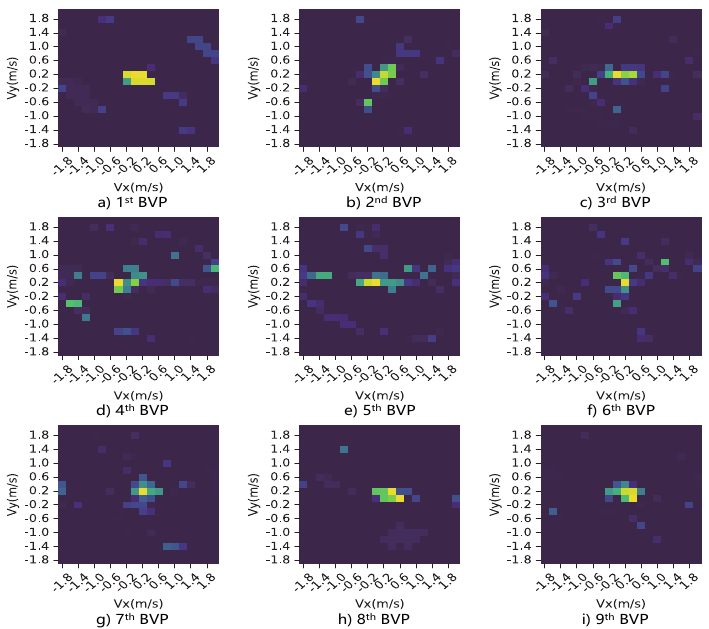
Figure 6. This is a part of BVP sequence corresponding to the motion, “push and pull”, where the principal signal power components are rendered in all